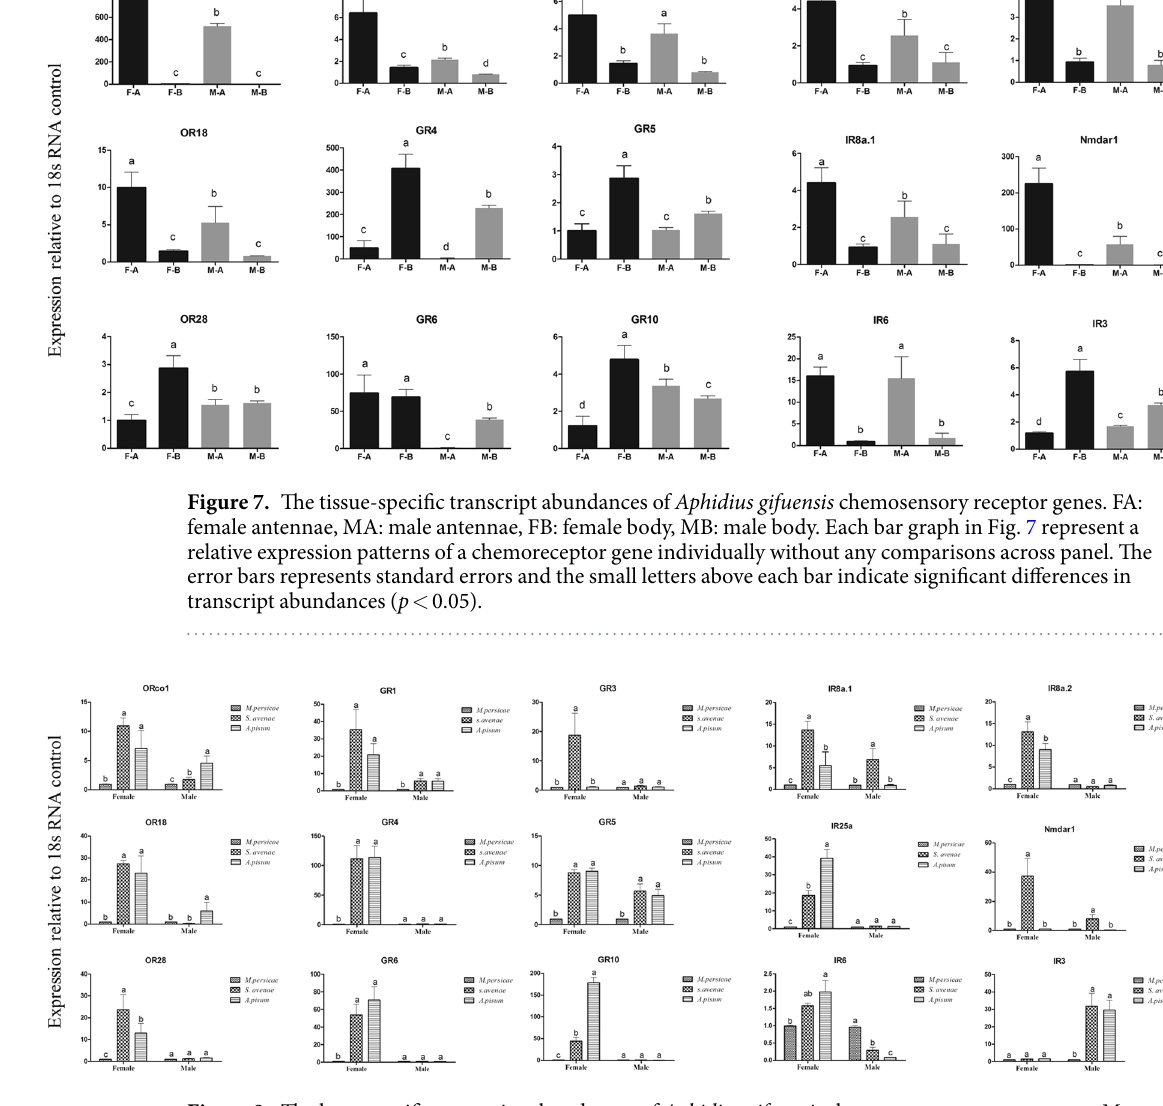
Figure 8. The host-specific transcript abundances of Aphidius gifuensis chemosensory receptor genes. M . persicae : A . gifuensis reared on the green peach aphid, Myzus persicae , for at least 1 year; S . avenae : A . gifuensis reared on the English grain aphid, Sitobion avenae , for at least 1 year; A . pisum : the A . gifuensis reared on the pea aphid Acyrthosiphon pisum , for at least 1 year. Each bar graph in Fig. 8 represent a relative expression patterns of a chemoreceptor gene individually without any comparisons across panel. The error bars represents standard errors and the small letters above each bar indicate significant differences in transcript abundances ( p <